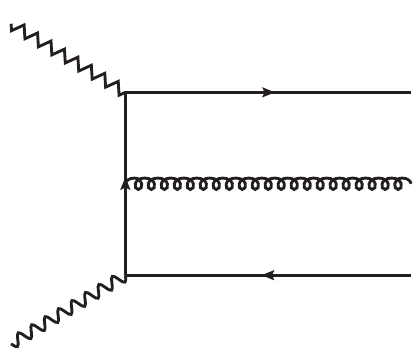
Figure 4 . Diagrammatical representation of the three-particle contribution to the QCD amplitude F (cid:22) ( p; q ) de(cid:12)ned in (3.3) at tree